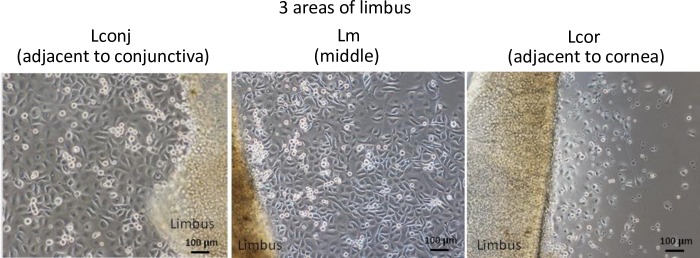
Limbal explant cultures.Representative limbal explant cultures from Lconj, Lm, and Lcor at day 7. All outgrowths included small cuboidal cells with high nucleus-to-cytoplasm ratios (scale bar = 100 μm).